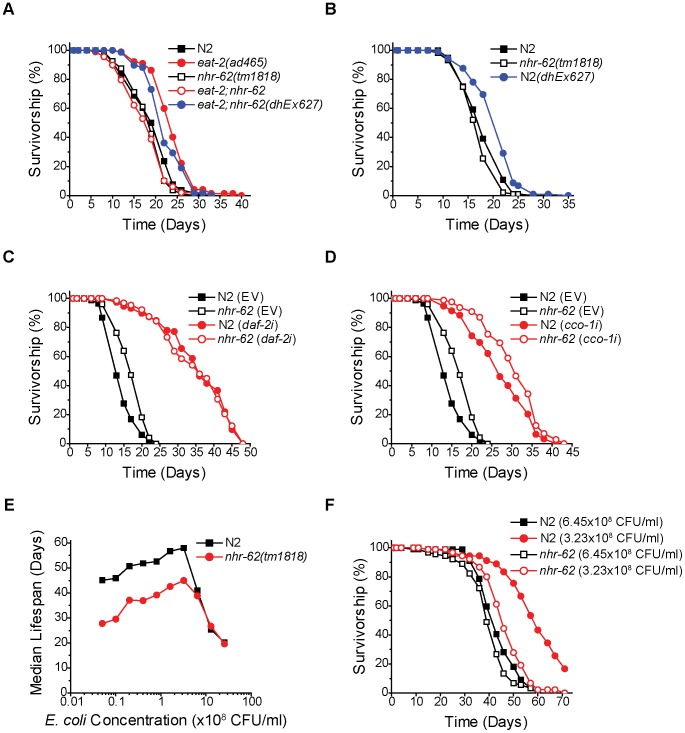

nhr-62 specifically regulates DR-induced longevity.(A) Survivorship curves for wild-type (N2), eat-2(ad465), nhr-62(tm1818), eat-2;nhr-62, and eat-2;nhr-62(dhEx627). Extra chromosomal array dhEx627 (carrying a wild-type nhr-62) in eat-2;nhr-62 resulted in a significant increase in lifespan compared to both nhr-62(tm1818) and eat-2;nhr-62 mutants (p<0.001). (B) Wild-type (N2) worms with dhEx627 exhibited a significant increase in lifespan compared to wild-type (p<0.001). See Figure S2 for physiologic traits of overexpression. (C,D) Both wild-type (N2) and nhr-62(tm1818) worms fed daf-2 RNAi or cco-1 RNAi had a significant increase in lifespan when compared to controls (p<0.001). (E) BDR curve for wild-type (N2) and nhr-62(tm1818) worms. The lifespan of wild-type and nhr-62(tm1818) were not different at the three most concentrated food dilutions, but were significantly different at the remaining 7 dilutions (p<0.001). (F) Survivorship curves for wild-type (N2) and nhr-62(tm1818) fed either 6.45×108 CFU/ml or 3.23×108 CFU/ml. p-values calculated by the log-rank test.